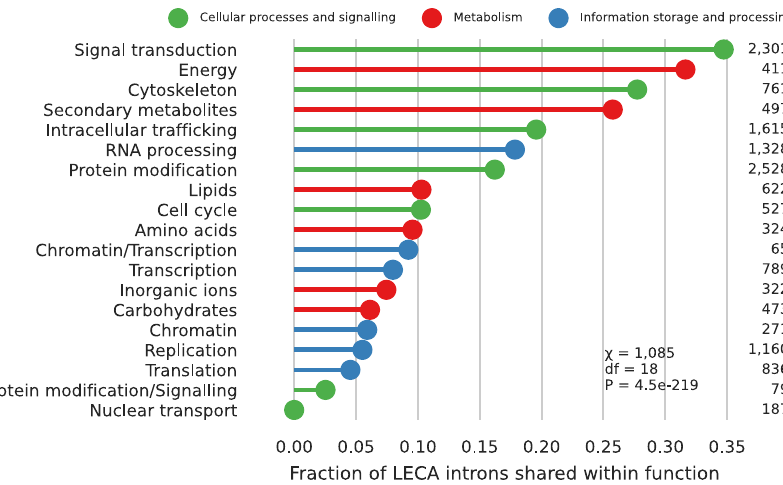
Fig. 2 Fraction of shared LECA introns between pairs of KOGs in a cluster with the same function. Sixty-nine percent of pairwise comparisons were signi fi cant, including all but one with nuclear transport (Supplementary Data 3). Numbers indicate the number of LECA introns. Only functions with at least ten LECA introns and ten pairs are